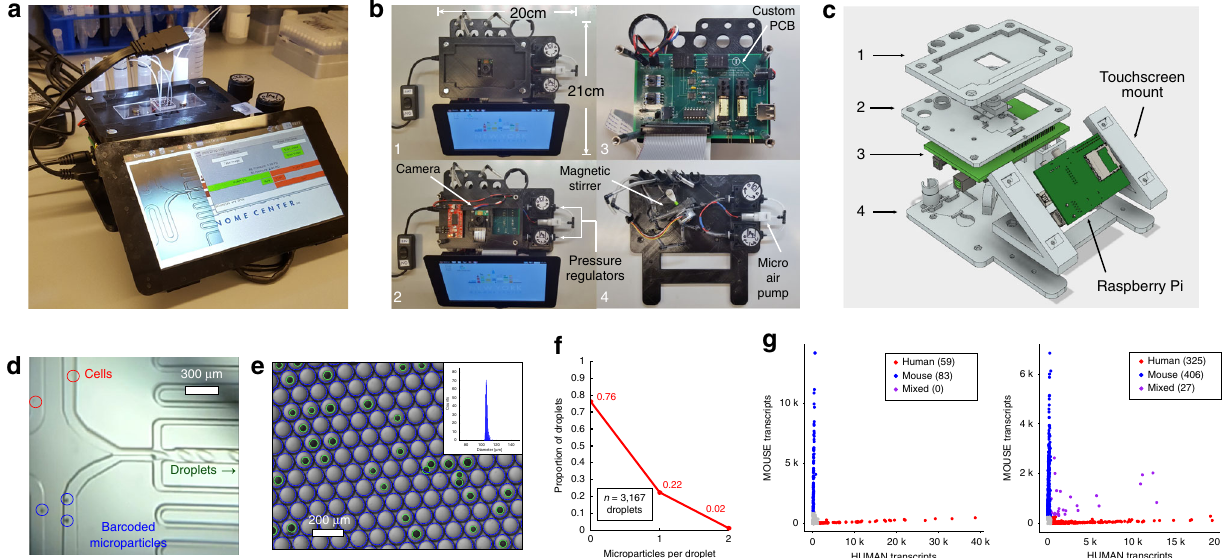
Fig. 1 Micro fl uidic control instrument design and validation. a Picture of the micro fl uidic control instrument performing a Drop-seq run. b Top down views of multi-tiered instrument. Levels 1 – 4 contain assorted components for instrument operation. c 3D rendering of the instrument with levels corresponding to those in b . Components in light gray are 3D printed. d Microscope image screen capture directly from the instrument. Cells and barcoded microparticles are visualized easily on the screen. e Microscope image of droplets output from the instrument. Droplets and microparticles are detected via image analysis software as blue circles and green circles respectively. Inset: droplet diameter distribution histogram. f Microparticle loading distribution into droplets as measured via automated image analysis is consistent with Poisson loading. g Species mixing experiments using mouse (3T3) and human (HEK293) cells at total cell concentrations of 75 cells/ µ l (left) and 300 cells/ µ l